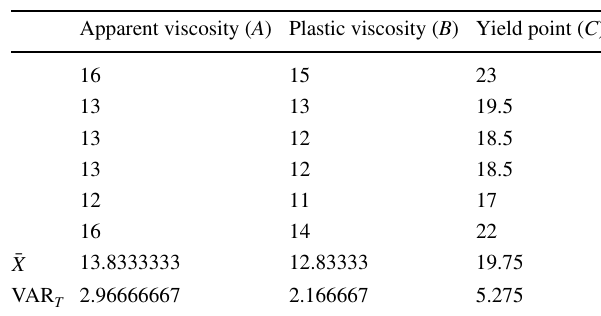
Table 1 Statistical evaluation for each